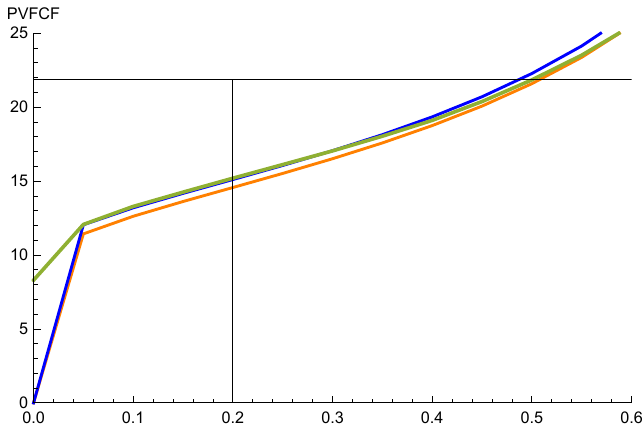
Figure 6. Quantile function of S (thick green), S l (blue), and S u (orange), for different p